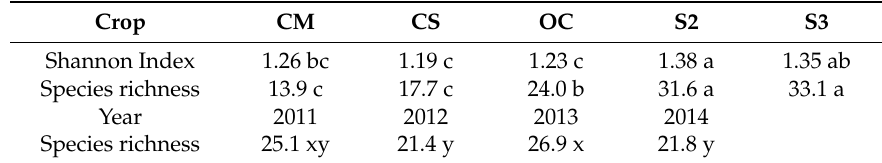
Table 2. Mean weed species richness and Shannon diversity index in the different crops. CM: cereal